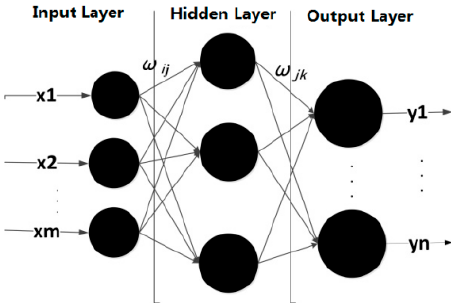
Figure 1. Back propagation neural network three-layer model.